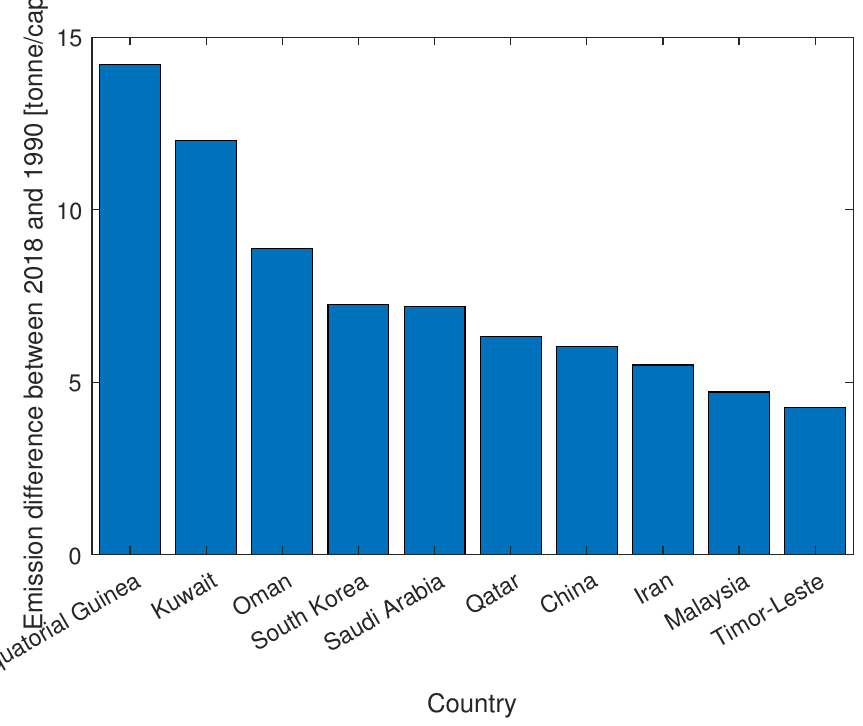
Figure 8. The difference between the GHG emissions measured in 2018 and 1990. The top ten most in- creased countries. The absolute scale can focus on the global contribution of countries to GHG